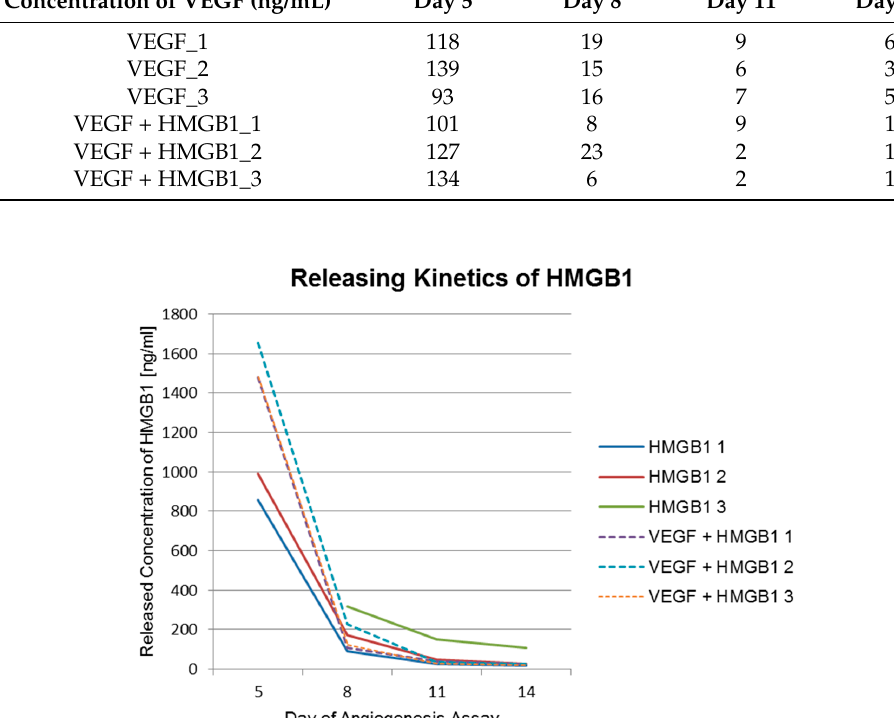
Table 3. Releasing kinetics of VEGF. Results of VEGF ELISA. Concentrations VEGF released by scaffolds functionalized with VEGF (VEGF_1 to VEGF_3), respectively with a combination of VEGF and HMGB1 (VEGF + HMGB1_1 to VEGF + HMGB1_3) were measured at different points in time using sandwich ELISA in (ng/mL).